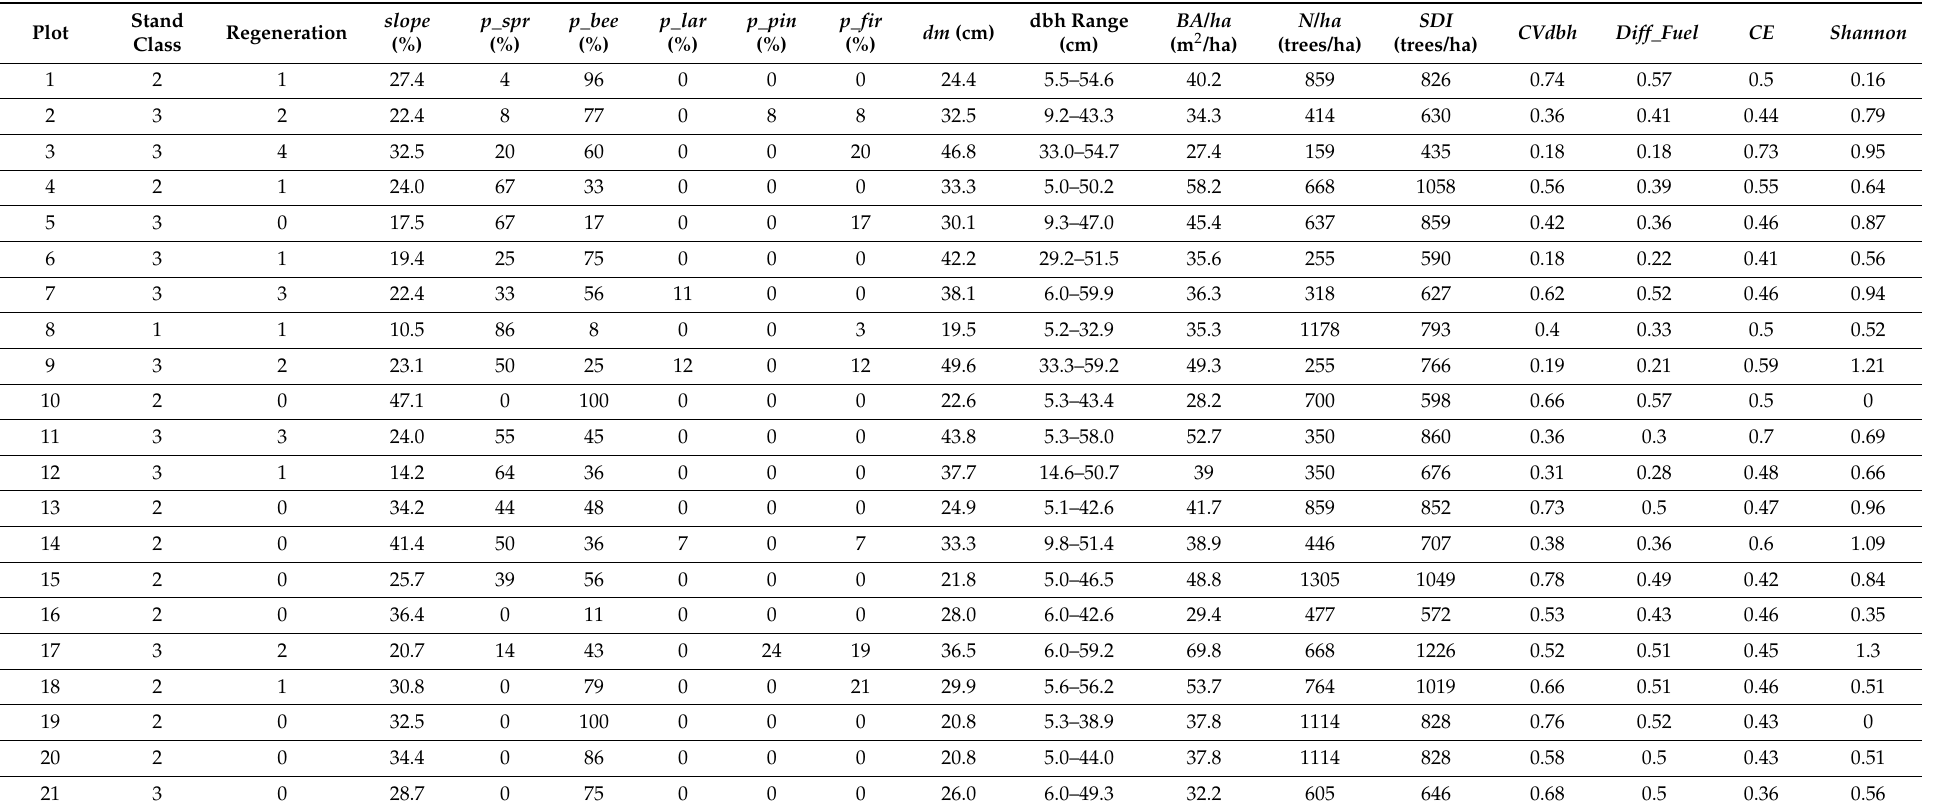
Table A1. Plot descriptions of the 21 sample plots and summary statistics of sample plots: slope, slope of sample plot; p_spr, proportion of Norway spruce; p_bee, proportion of Common beech; p_lar, proportion of European larch; p_pin, proportion of Scots pine; p_fir, proportion of Silver fir; dm, diameter of mean basal area tree; BA/ha, basal area per hectare; N/ha, number of trees per hectare; SDI, stand density index; CVdbh, coefficient of variation of diameter at breast height; Diff_Fuel, dbh differentiation according to Füldner; CE, Clark and Evans aggregation index; shannon, Shannon